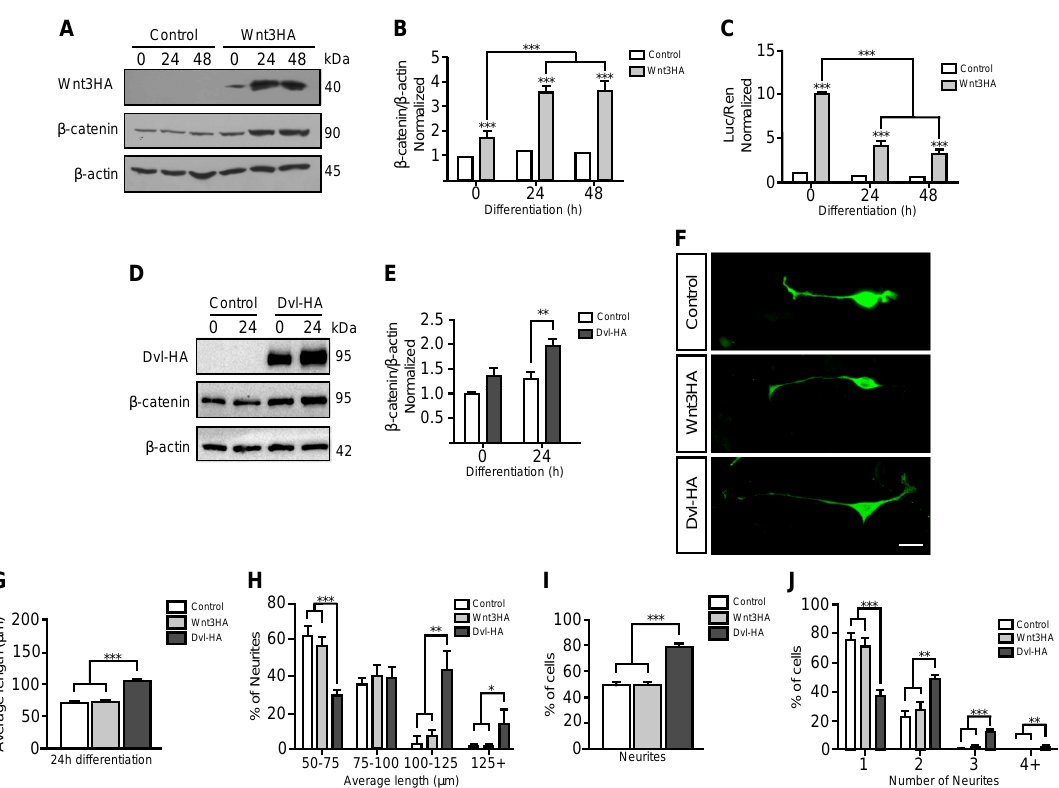
Figure 3. NSC-34 cells overexpressing Wnt3HA do not modify their morphological differentiation but induce acetylcholine receptor aggregation on co-cultured myotubes. ( A ) Total protein extracts were obtained from NSC-34 cells transfected to overexpress Wnt3HA at 0, 24, and 48 h of differentiation. Control cells were transfected with empty pBluescript plasmid. Protein extracts were subjected to Western blot analyses using anti HA, anti β -catenin, and anti β -actin antibodies, the latter used as loading control. ( B ) The plot represents the quantification of the band intensity ratio between β -catenin and β -actin expressed as the average ± SEM of three independent experiments. ( C ) NSC-34 cells were co-transfected with Wnt3HA and the Wnt reporter Topflash plus the pRLSV40 Renilla control plasmids and subsequently differentiated for the indicated times. The graph shows the normalized reporter gene activity (Luciferase Topflash/Renilla; Luc/Ren). Data are expressed as the average ± SEM of three independent experiments performed by quadruplicate. ( D ) Total protein extracts from NSC-34 cells overexpressing Dvl-HA at 0 and 24 h of differentiation were subjected to Western blot analyses using anti HA, anti β -catenin, and anti β -actin antibodies. Control cells were transfected with a plasmid coding for yellow fluorescent protein (YFP). ( E ) The plot represents the quantification of the band intensity ratio between β -catenin and β -actin expressed as the average ± SEM of three independent experiments. ( F ) NSC-34 cells transfected to express tdTomato, Wnt3HA, or Dvl-HA were differentiated for 24 h, fixed, and stained with an anti MAP1B antibody (Bar, 20 µ m). Morphological parameters were measured using ImageJ. These include ( G ) the average length of neurites, ( H ) the distribution of neurite length, ( I ) the proportion of cells bearing neurites, and ( J ) the percentage of cells having different numbers of neurites. Plots are the average ± SEM of three independent experiments (* p < 0.05; ** p < 0.01; *** p < 0.001;